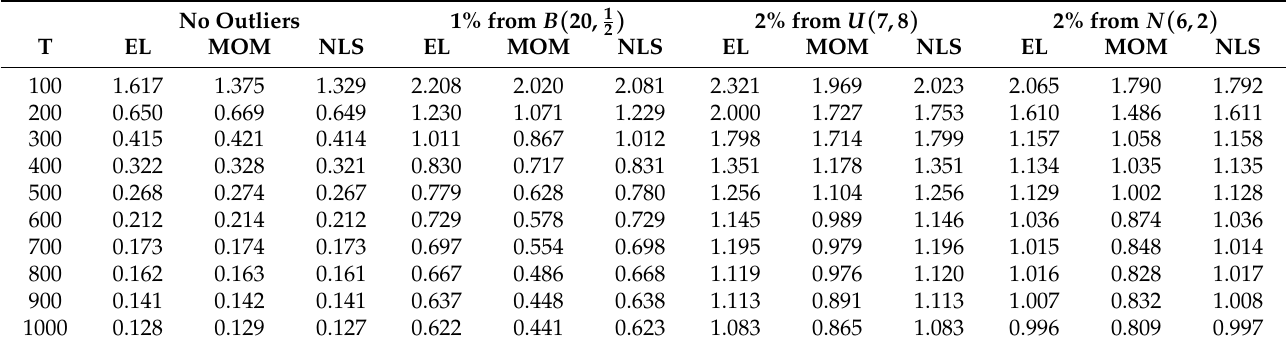
Table 1. Mean Square Error (MSE) for (cid:98) θ NLS , (cid:98) θ MOM and (cid:98) θ EL in Example 1.